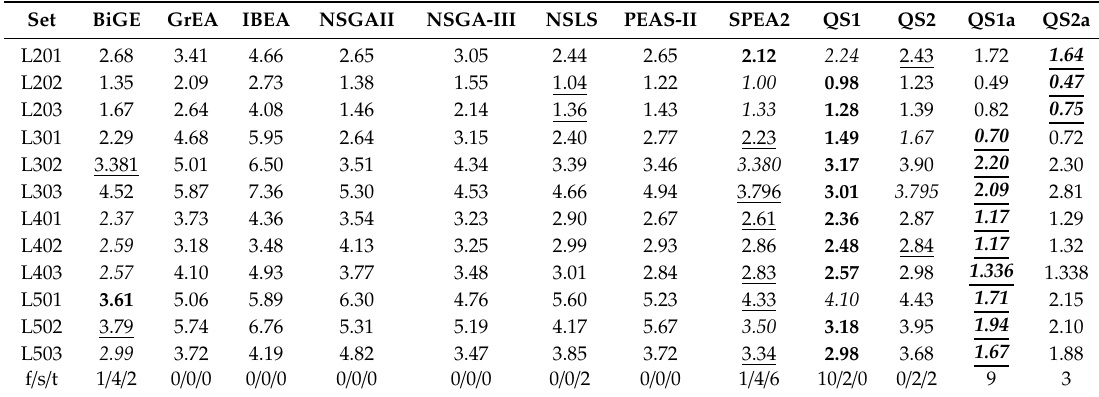
Table 3. Mean IGD values of 12 approaches for instances.